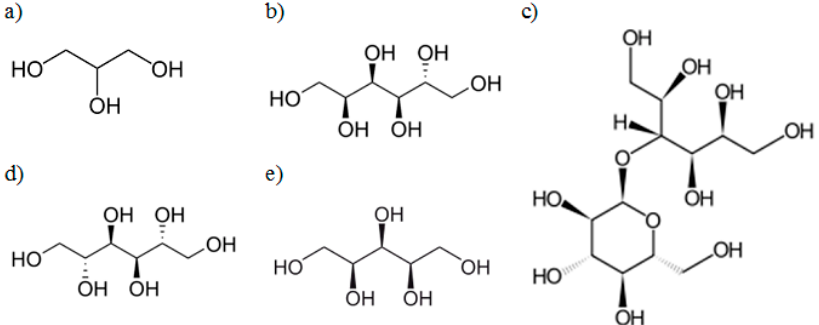
Figure 1. Chemical structure of the plasticizers used: glycerol ( a ); sorbitol ( b ); maltitol ( c ); mannitol ( d ) and xylitol ( e ).